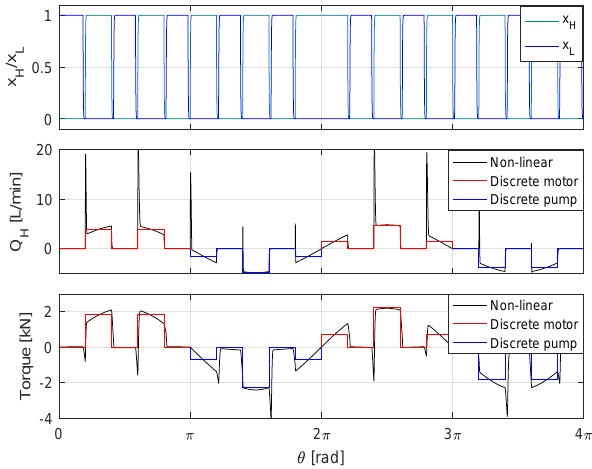
Figure 3: Comparison of non-linear and discrete model of the digital displacement